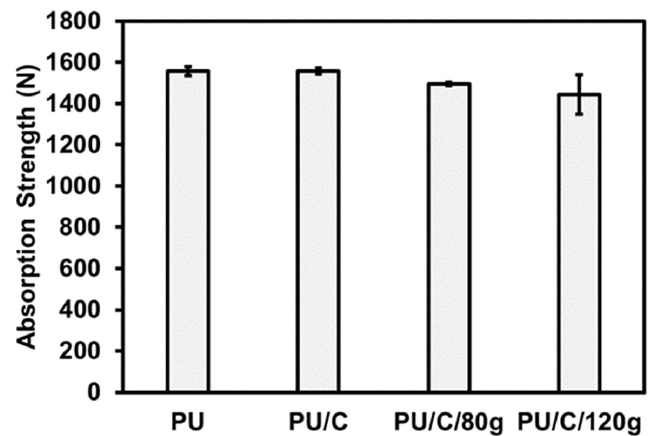
Figure 3. Buffer absorption results of the PU foam composite planks.